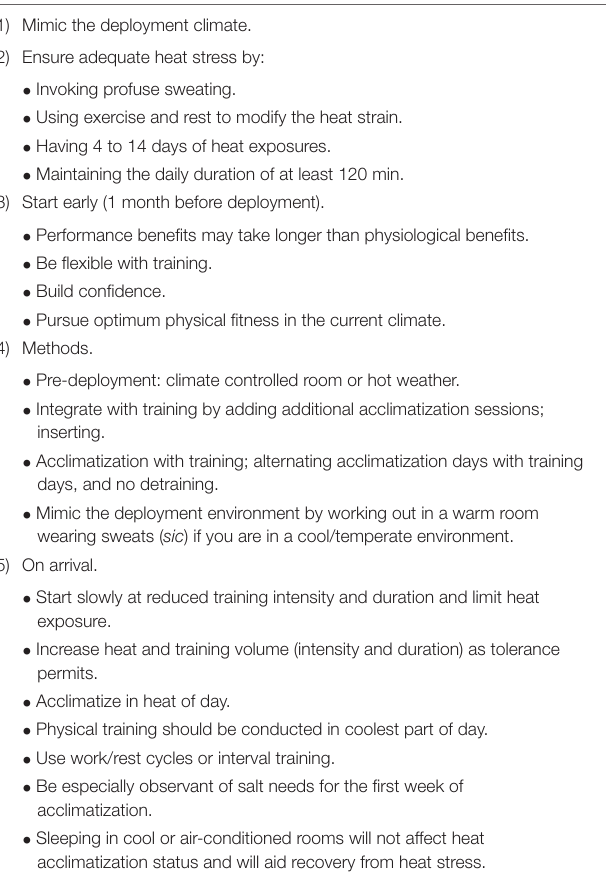
TABLE 1 | Heat acclimatization strategies that can be considered before and after military deployment to a hot region (STO/NATO, 2013). (1) Mimic the deployment